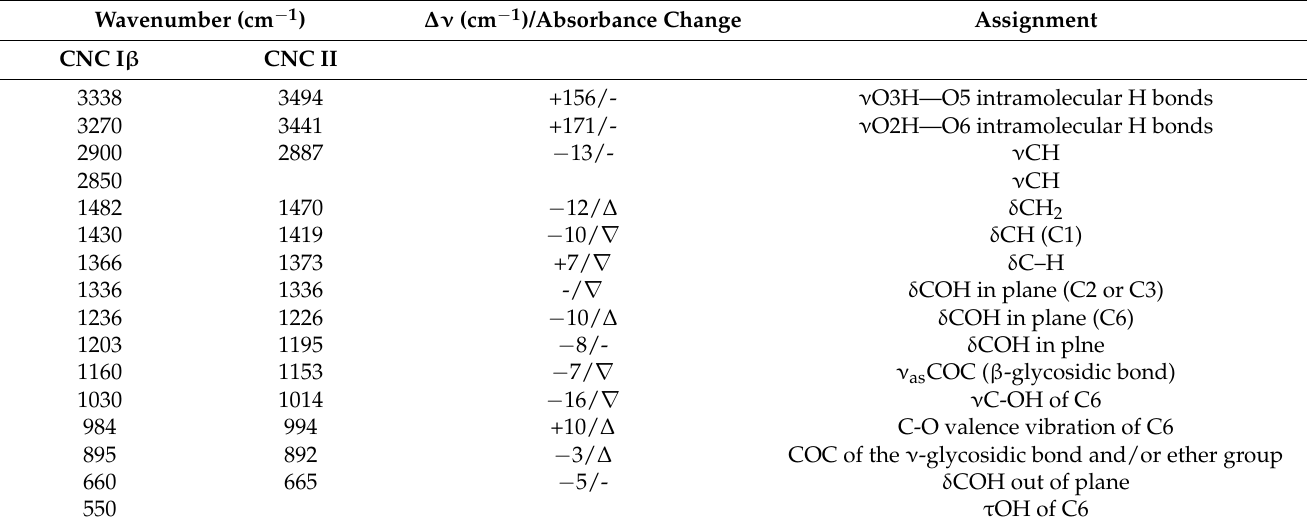
Table 5. The assignment of the main FTIR bands of CNC I β (CNC-CF) and CNC II (CNC-MF, CNC-S, CNC-NS) according to references, and the band shift and absorbance intensity variation from cellulose I β and cellulose